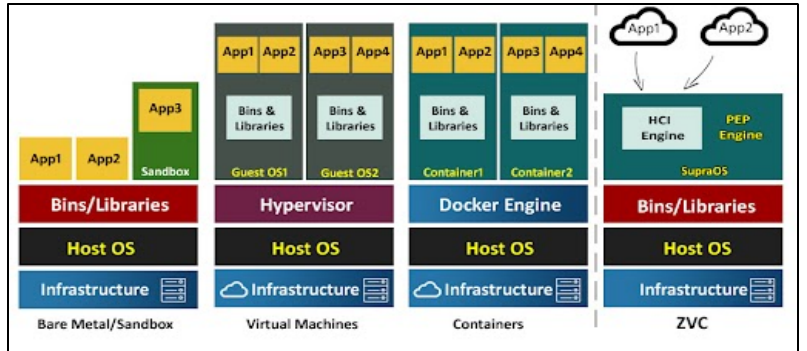
Figure 3. State-of-the-art cybersecurity approaches compared with ZVC’s zero attack surface ap- proach.